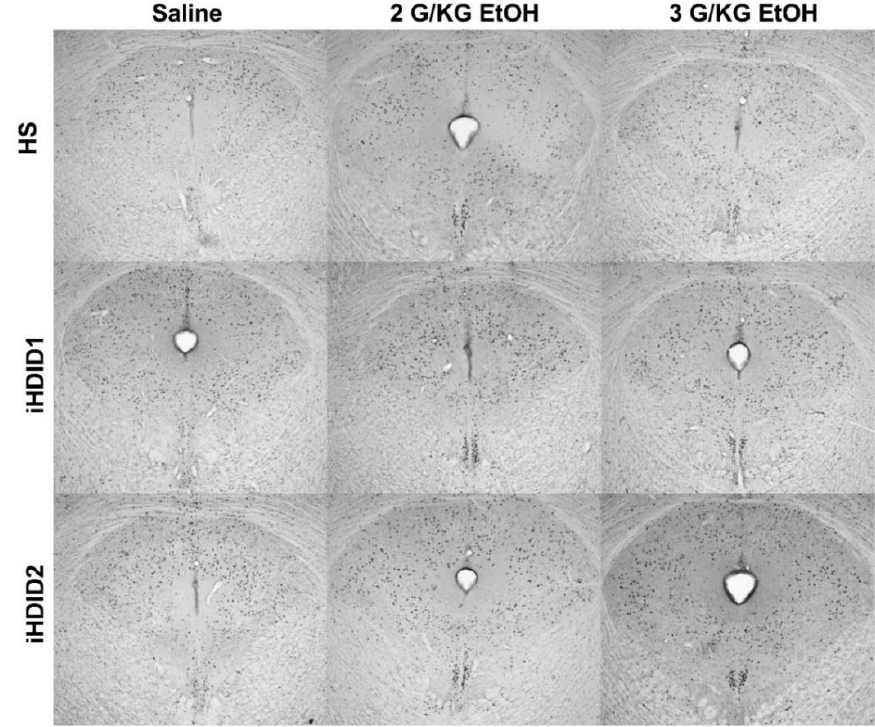
Figure 11. Periaqueductal Gray. Representative images of c-Fos expression in the PAG across genotype and treatment types.